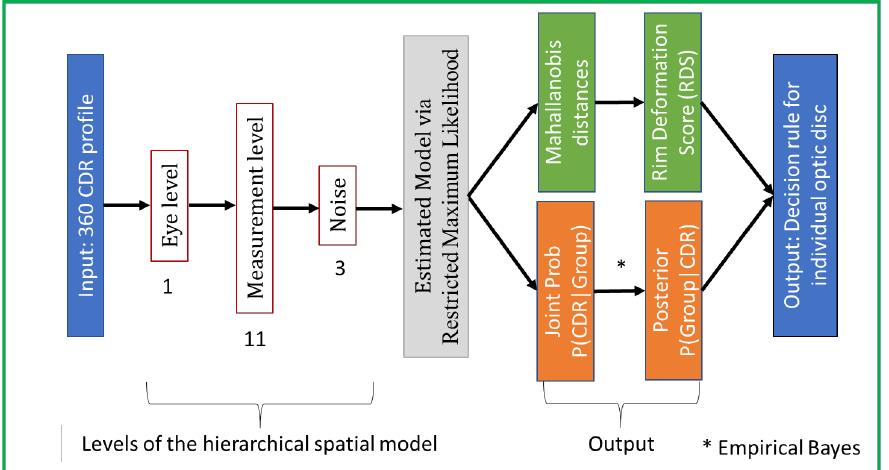
Figure 4. Framework of our EffUnet model. The details of Block 1–7 are shown in Figure 3. The output image (green rectangle on the right) is Output 1 in the whole architecture shown in Figure 2.